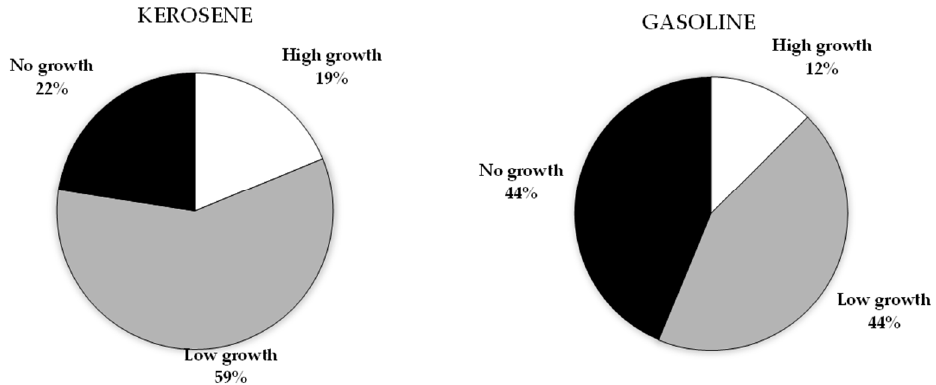
Figure 1. Growth of thermophilic bacilli isolated from Eolian Islands (Italy) in NSW medium plus hydrocarbons (2%, v / v ), kerosene, or gasoline as unique carbon source. High growth (OD 600 nm ≥ 0.5), low growth (OD 600 nm between 0.2 and 0.5) or no growth (OD 600 nm ≤ 0.2). In the presence of kerosene, 15 strains (18.75%) grew well, and 47 strains (58.75%) showed low growth. Only 10 strains (12.50%) showed high growth with gasoline, and 35 (43.75%) exhibited low growth (Figure 1). Strains showing high growth levels in the pres- ence of kerosene (15) and gasoline (10) were selected for further investigation . The selected thermophilic bacilli, their growth characteristics, utilization of kerosene or gasoline (2% v / v ) as only carbon sources, and lipase production are reported in Table 2. The full list of 80 tested strains is reported in Table S1. Table 2. Thermophilic bacilli isolated from hydrothermal vents of Eolian Islands, optimal charac- teristics for growth, utilization of kerosene (Ker) or gasoline (Gasol) (2% v / v ) as only carbon sources, and enzymatic production on selected substrates.